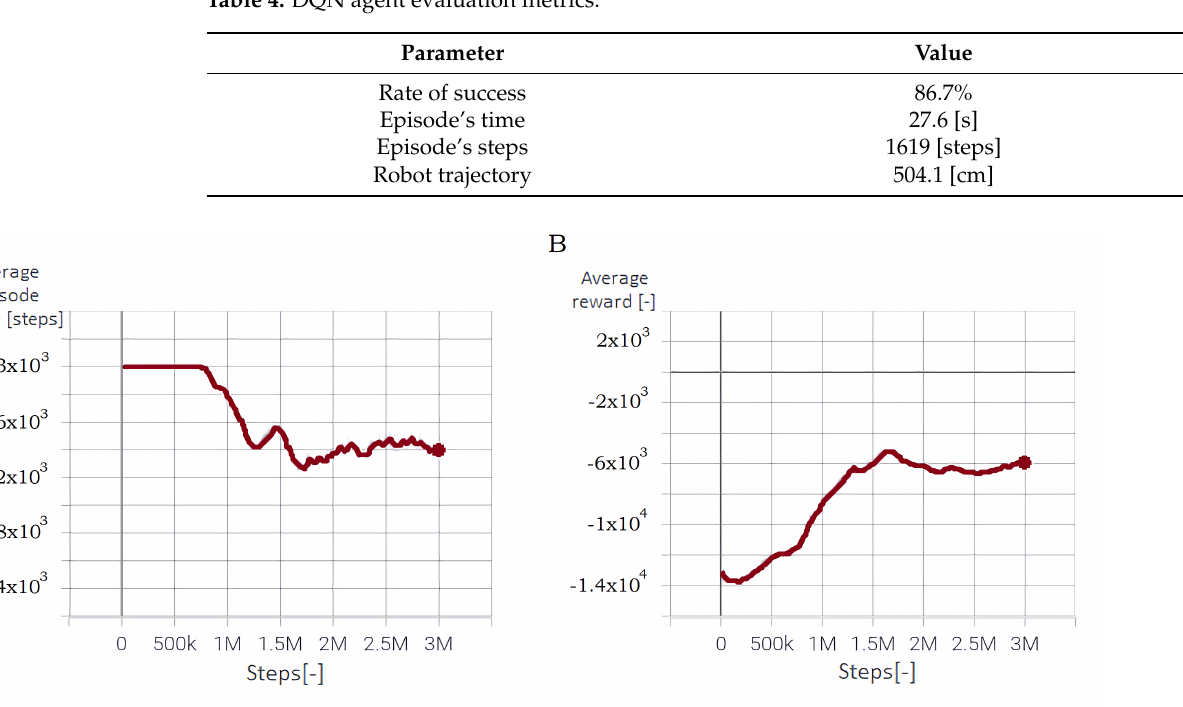
Table 4. DQN agent evaluation metrics.